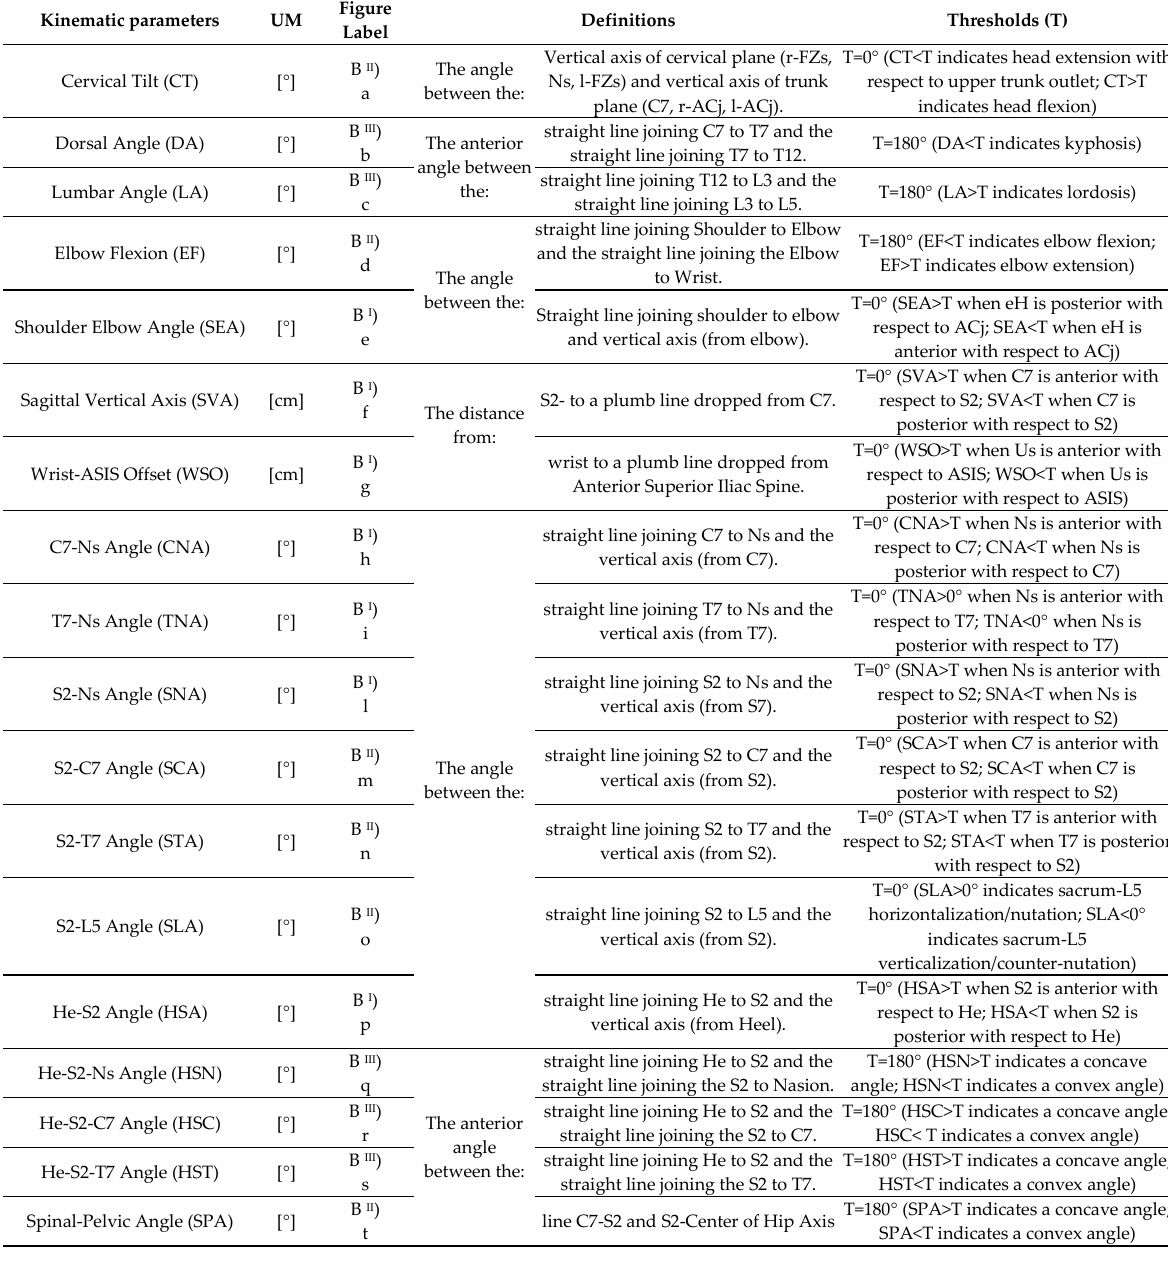
Figure 1. ( A ) DB-Total marker set protocol. ( B , C ) Graphic representation and definition of eighteen sagittal whole-body parameters. (Figures ( B ) show an adult healthy subject during walking at 20% of gait cycle). Additional DB-Total markers were circled in red with respect to Helen Hayes Medial Markers set ones [11] ( A ). 37 reflective markers were placed on nasion (Ns), frontozygomatic suture (FZs), spinous apophysis of C7 -T7 -T12 -L3 -L5 -S2, acromioclavicular joint (ACj), epicondylus humeri (eH), ulnar styloid (Us), anterior superior iliac spine (ASIS), greater trochanter (gT), medial (mEF) and lateral (lEF) epicondylus femoris, fibular head (Fh), medial (mM) and lateral (lM) malleoli, I ◦ –III ◦ and V ◦ metatarsal heads (MtH) and heel (He). UM (unit of measure). T (threshold: the line that defines the passage from one direction of movement to the opposite for each kinematic parameter, as shown on kinematic graphs in Figure 2). Vertical axes are represented as dashed